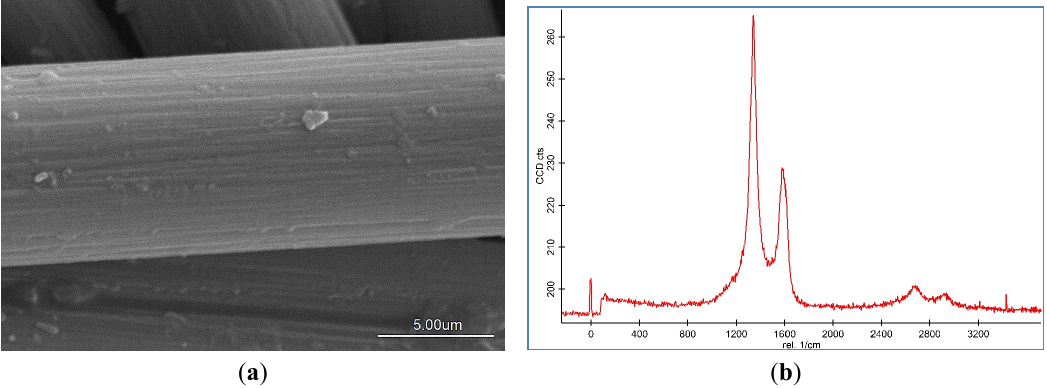
Figure 1. ( a ) Scanning electron microscopy (SEM) image; ( b ) Raman spectroscopy of pristine carbon fiber. carbon